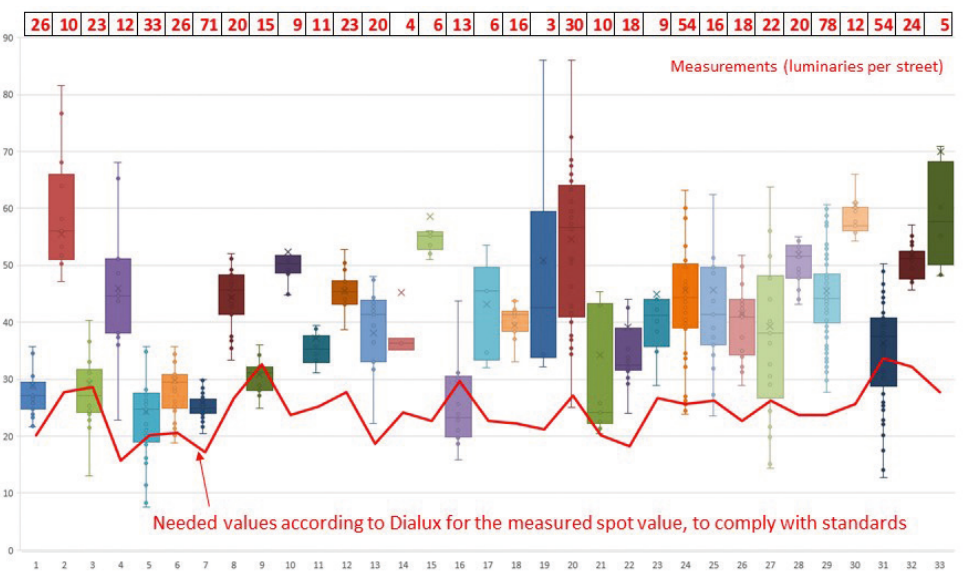
Figure 17. The measured illumination value distribution per street and needed minimums, according to